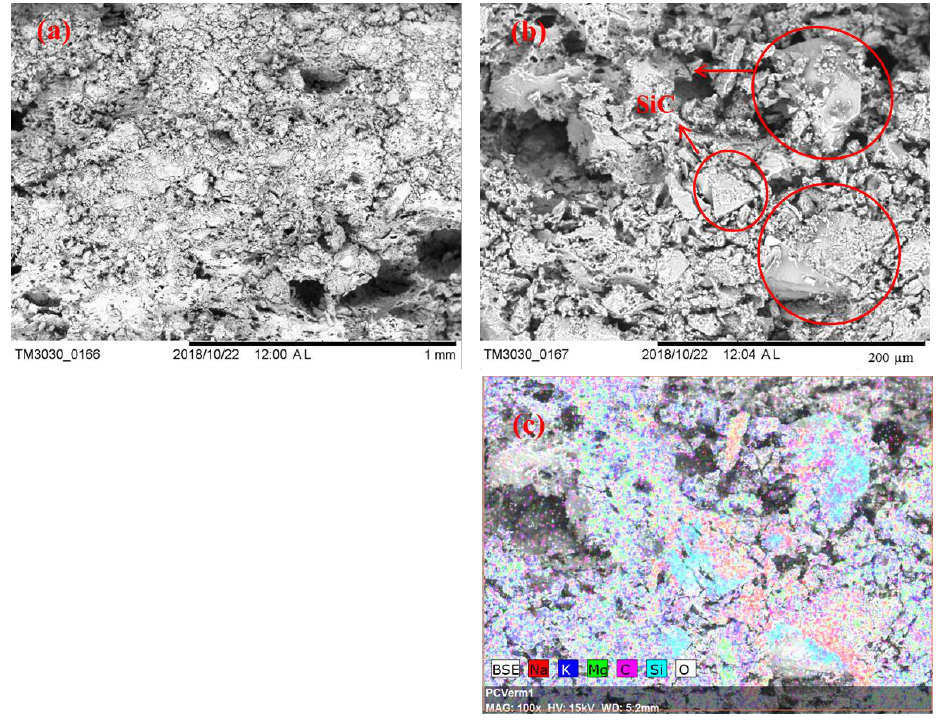
× ; ( b ) 500 × ; ( c ) EDS mapping,